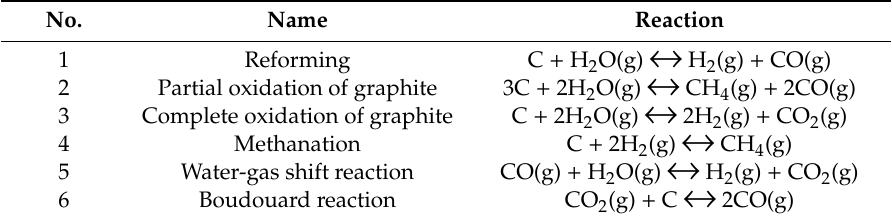
Table 1. Potential reactions of supercritical water with carbon.